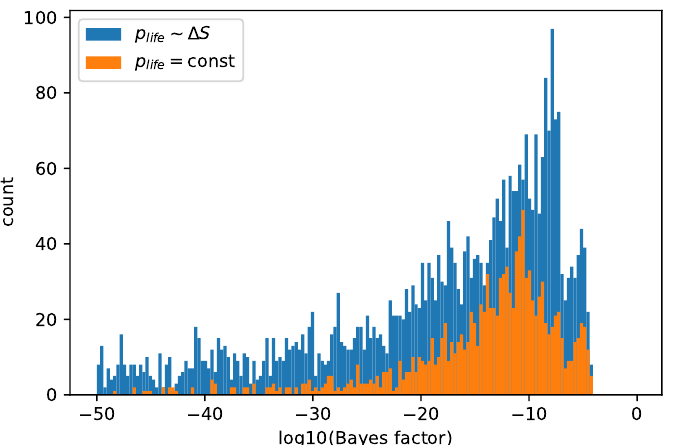
Figure 1. Histogram of Bayes factors, representing the probability of our observations within the multiverse framework for different habitability criteria combinations. These are computed by com- pounding the probabilities of the eight observations described in the text. While some combinations lead to reasonable probabilities (the largest having a total value of 5.91 ˆ 10 ´ 5 , corresponding to an average probability of 0.36 per observation, out of a maximum 0.5), others are extraordinarily low. While the overall hypothesis that the emergence of life depends linearly on disequilib- rium produced is neither favored nor disfavored by the multiverse, the various sources of disequilibrium have varying levels of support within the multiverse framework. In Table 2, we display the best combination of habitability hypotheses for each disequilibrium source considered in the text, along with the associated Bayes factor relative to the null